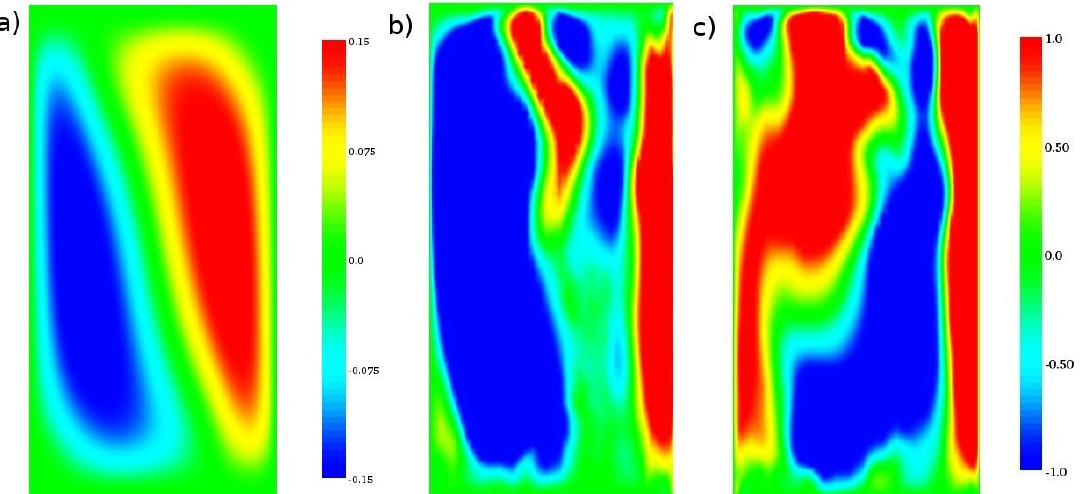
Figure 9. Instantaneous snapshots of flow axial velocity in a vertical plane through the diameter for ( a ) flow without bubbles and ( b , c ) flow with bubbles. The sections ( b , c ) refer to the azimuthal location θ c and θ c + π /4 for the time equal to 530,